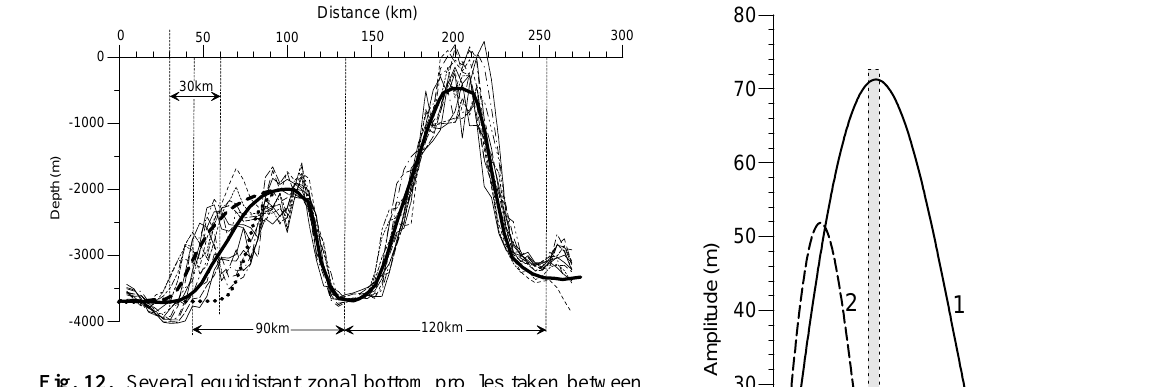
Fig. 12. Several equidistant zonal bottom profiles taken between 20.25 ◦ N and 20.75 ◦ N (see Fig. 3) are shown by thin lines of dif- ferent style. Thick solid line represents an average bottom profile with thick dashed and dotted lines showing the divergence.